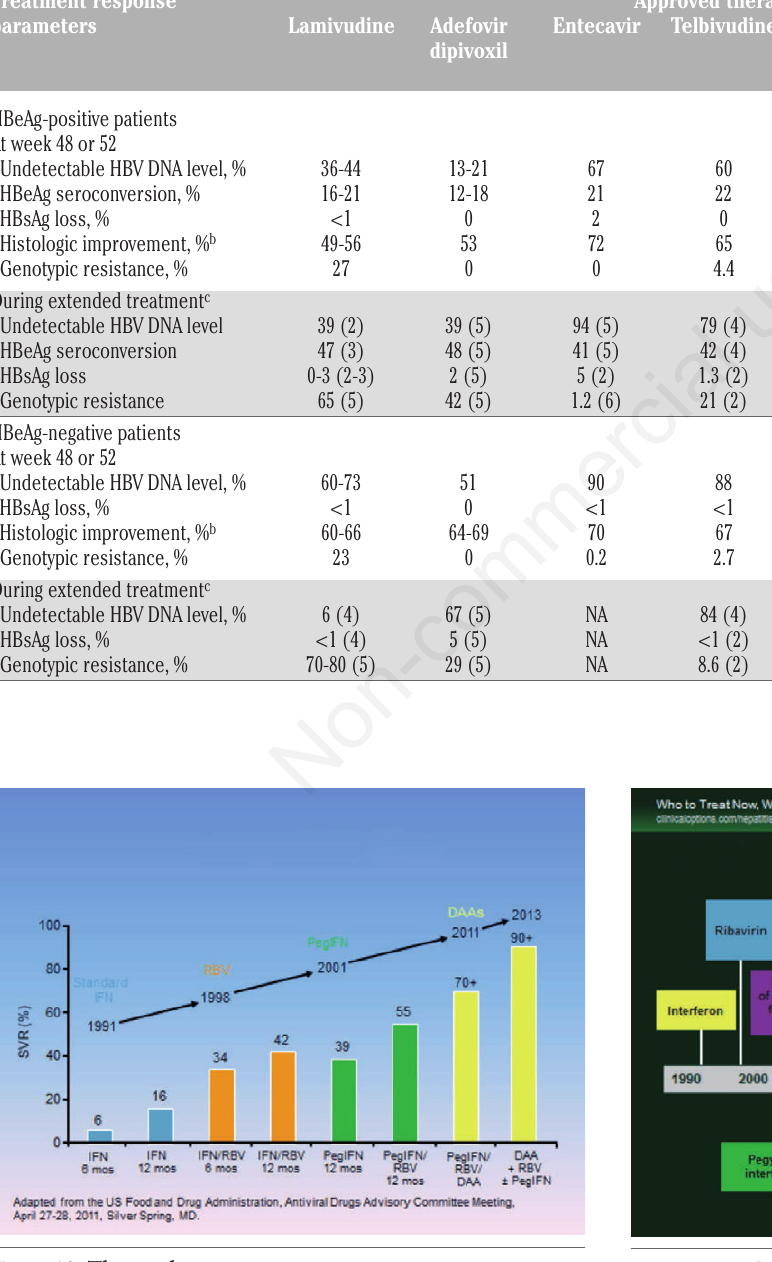
Figure 10. The good news. Figure 11. HCV therapy: past, present and future.